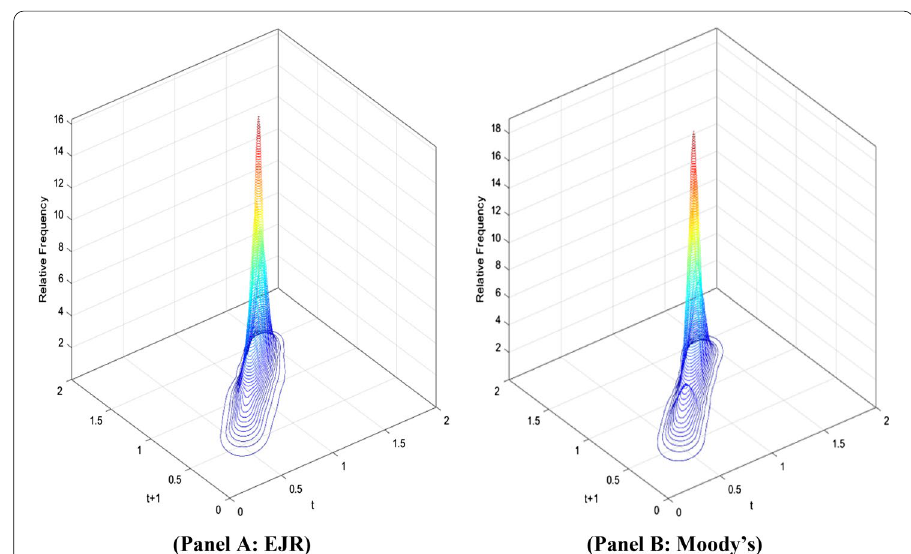
Fig. 1 Three-dimensional plot of transition probability kernel for relative credit ratings assigned by EJR and Moody’s from 2011 to 2018